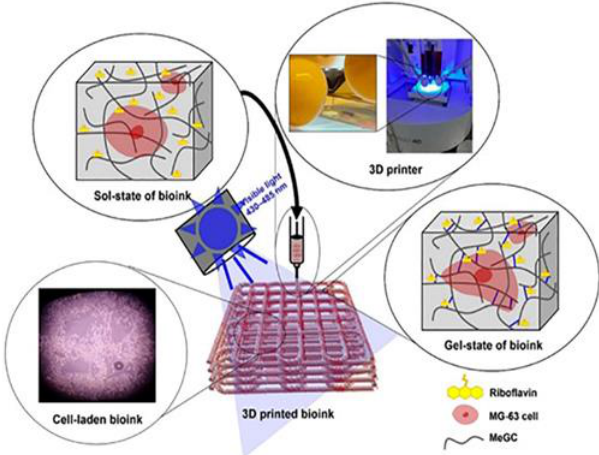
Figure 8. Schematic illustration for preparation for 3D bioprinting of MeGC bioink. Reprinted from [20], Copyright 2022, Elsevier.